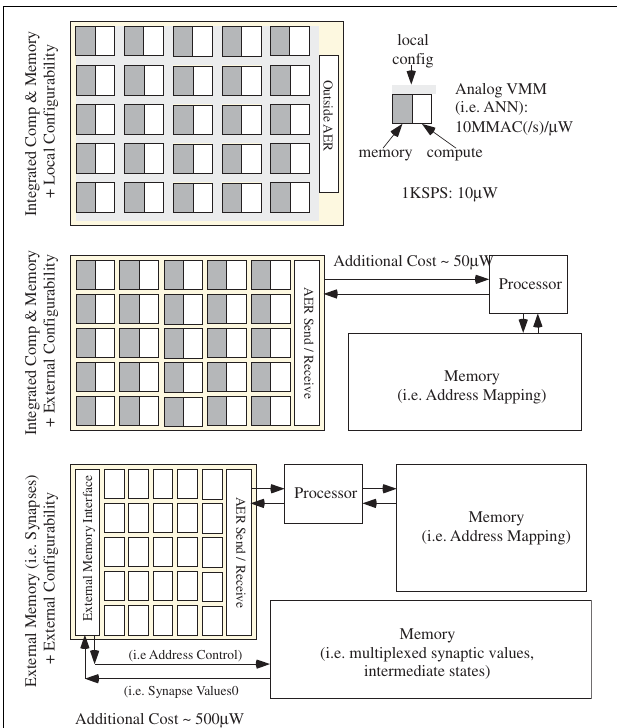
FIGURE 23 | Illustration of the costs of external communication for configurability and storage. Where possible, we want data-flow operations where memory and computation are co-located with local routing/configurability. Moving configurability is moved off of the processing die substantially increases computational cost because of the power and complexity requirements for moving the data to an external processor/memory, even if next to the IC. Moving memory away from Processing, say for multiplexing Synaptic values, further increases the resulting power and complexity cost, even if the original device gets simplier and smaller. These schemes include rate encoded approaches encoding synapse values because of the increased event rate. We include values for a small network of 1000 neurons with 100 synapses operating with a 1 KSPS operating speed assuming a typical ANN (i.e., Vector-matrix multiplication) neuron